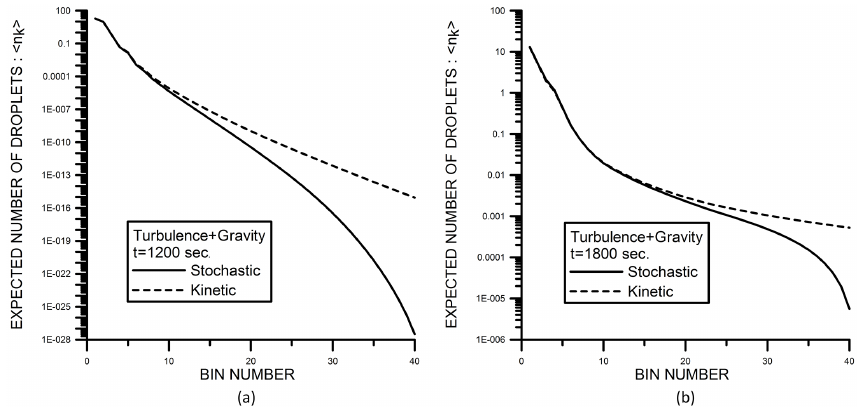
Figure 8. For the turbulent hydrodynamic kernel, comparison of the size distributions obtained from the stochastic master equation (solid line) with that of the KCE (dashed line) at t = 1200 and 1800s for a 1cm 3 system containing initially 20 droplets of 14µm and 10 droplets of 17µm. For the small end the size distributions are closely coincident, for the large end the two equations give different values.